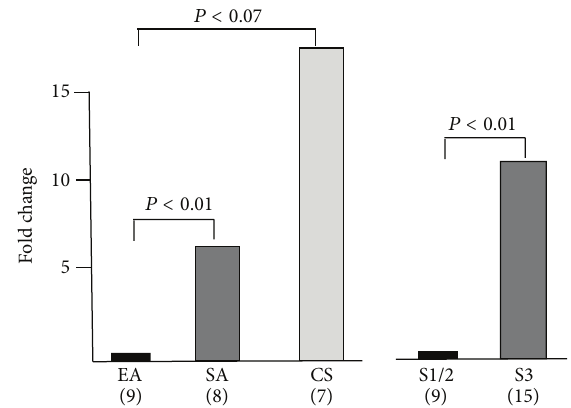
Figure 3: Relative PLAC1 expression among endometrial tumor types (left) and between tumor stages (right). Fold changes, assessed by ΔΔ Ct, between endometrioid adenocarcinoma (EA) and serous adenocarcinoma (SA) and between endometrioid adenocarcinoma (EA) and carcinosarcoma (CS) are 6.58 and 16.47, respectively. PLAC1 fold change between Stage 1 and 2 tumors (S1/2) and Stage 3 (S3)tumorsis10.41.Statisticalsignificanceisassessedbyatwo-tailed 𝑡 -test with unequal variances using normalized expression values ( Δ Ct). Sample sizes are shown.